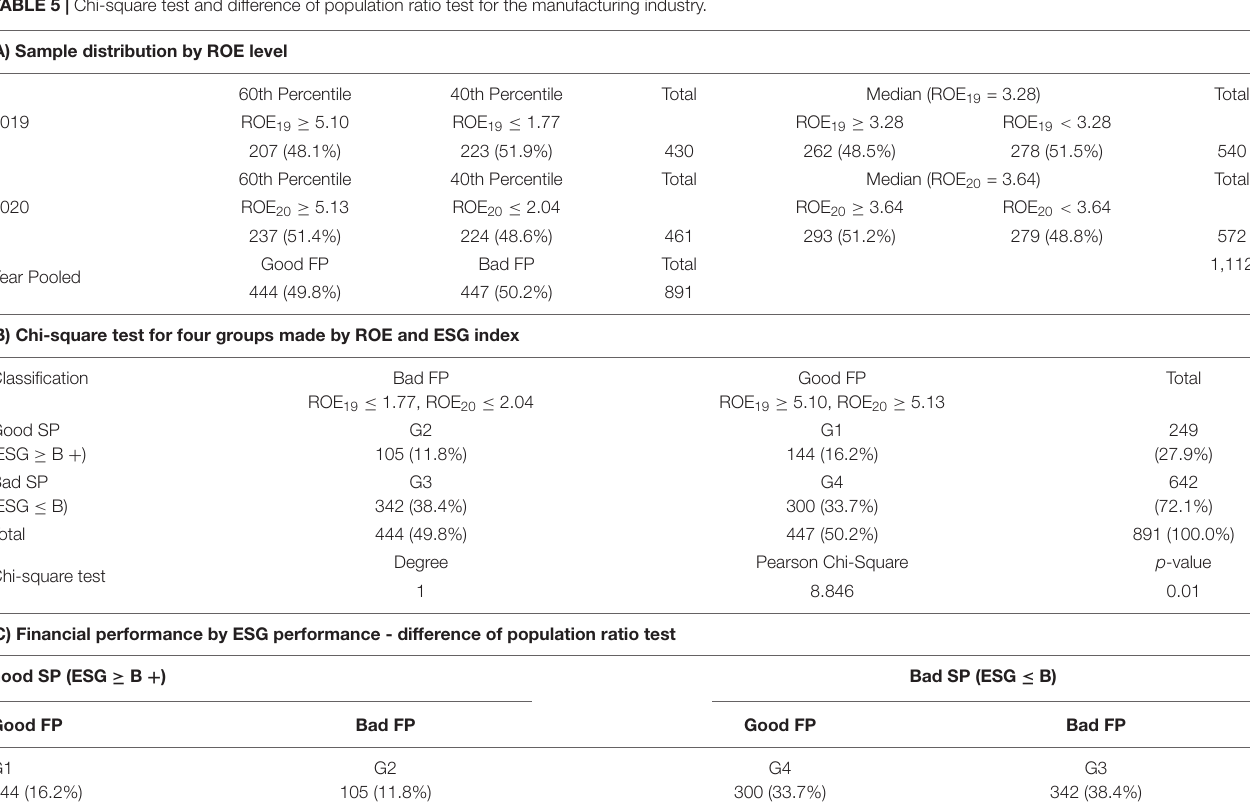
TABLE 5 | Chi-square test and difference of population ratio test for the manufacturing